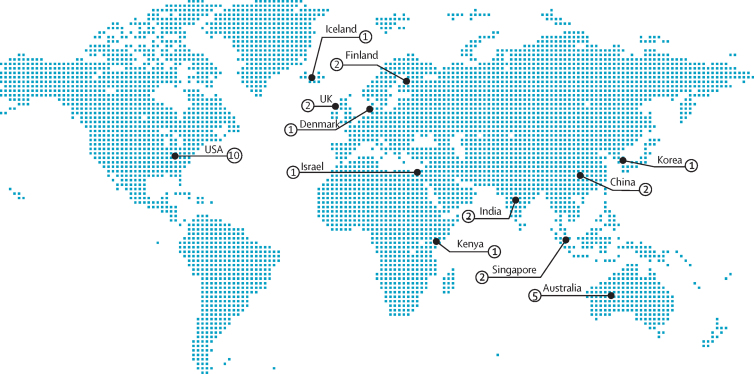
Global distribution of included studiesThe map shows the number of unique study cohorts from each country that were included in the systematic review.